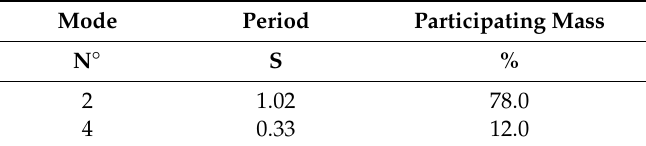
Table 3. Regular bridge—modal properties.